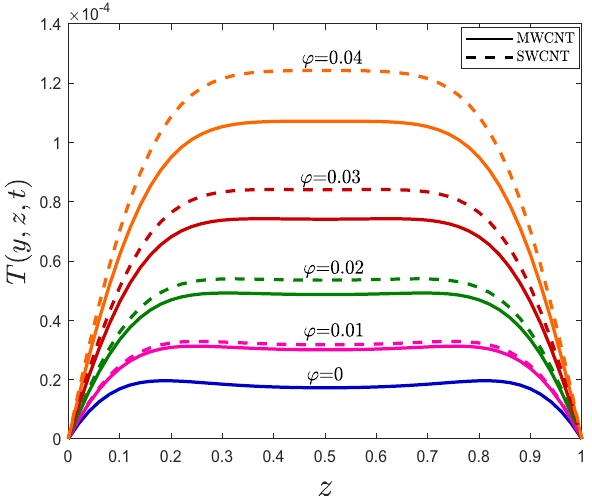
Figure 7. One-dimensional temperature profile for different values of ϕ .